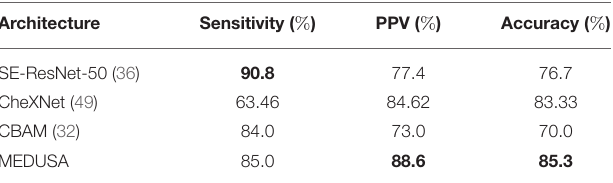
TABLE 5 | Sensitivity, positive predictive value (PPV), and accuracy of the proposed network (MEDUSA) on the test data from the RSNA RICORD COVID-19 severity dataset in comparison to other